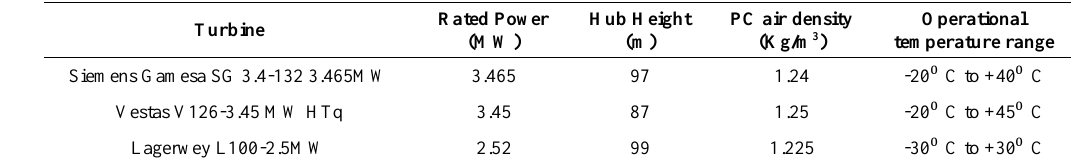
Table 2. Proposed turbine model